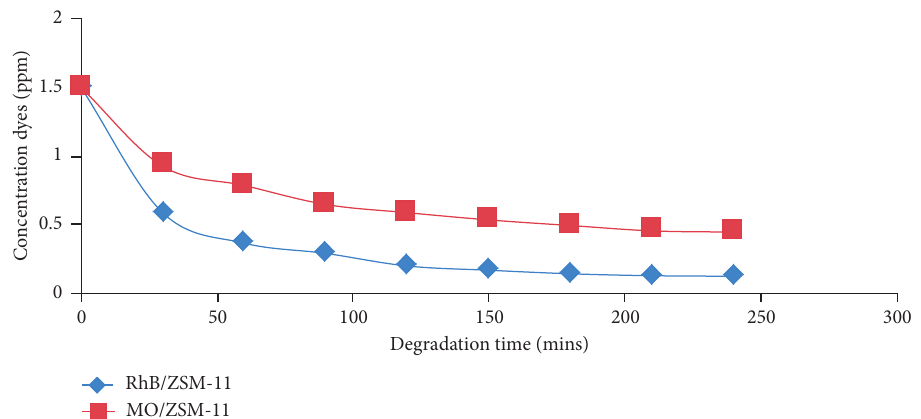
Figure 14: A photodegradation process of rhodamine blue and methyl orange showing the change in concentration with time.